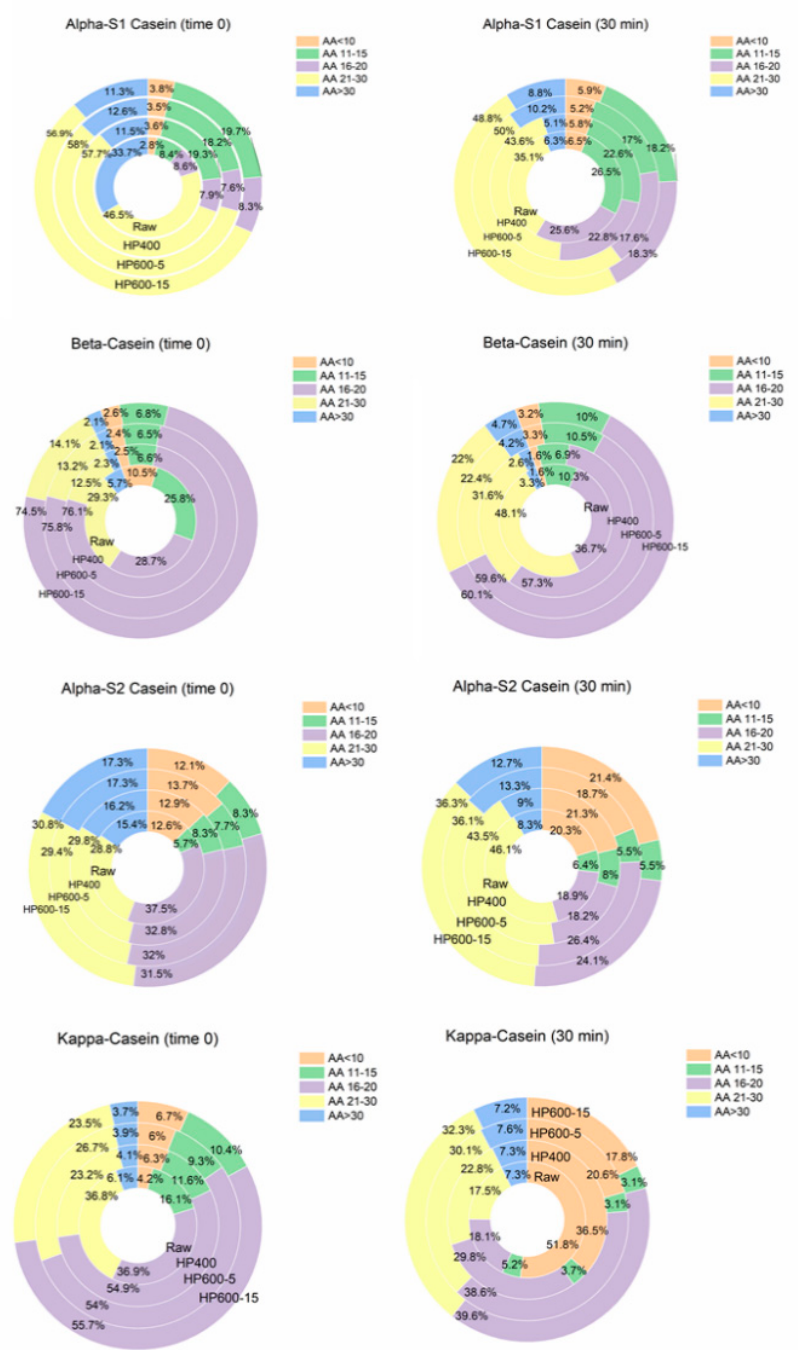
Figure 4. Peptide length distribution in percentage for individual caseins before and after gastric in vitro digestion in raw and three HPP-treated milks, including both adult and elderly.